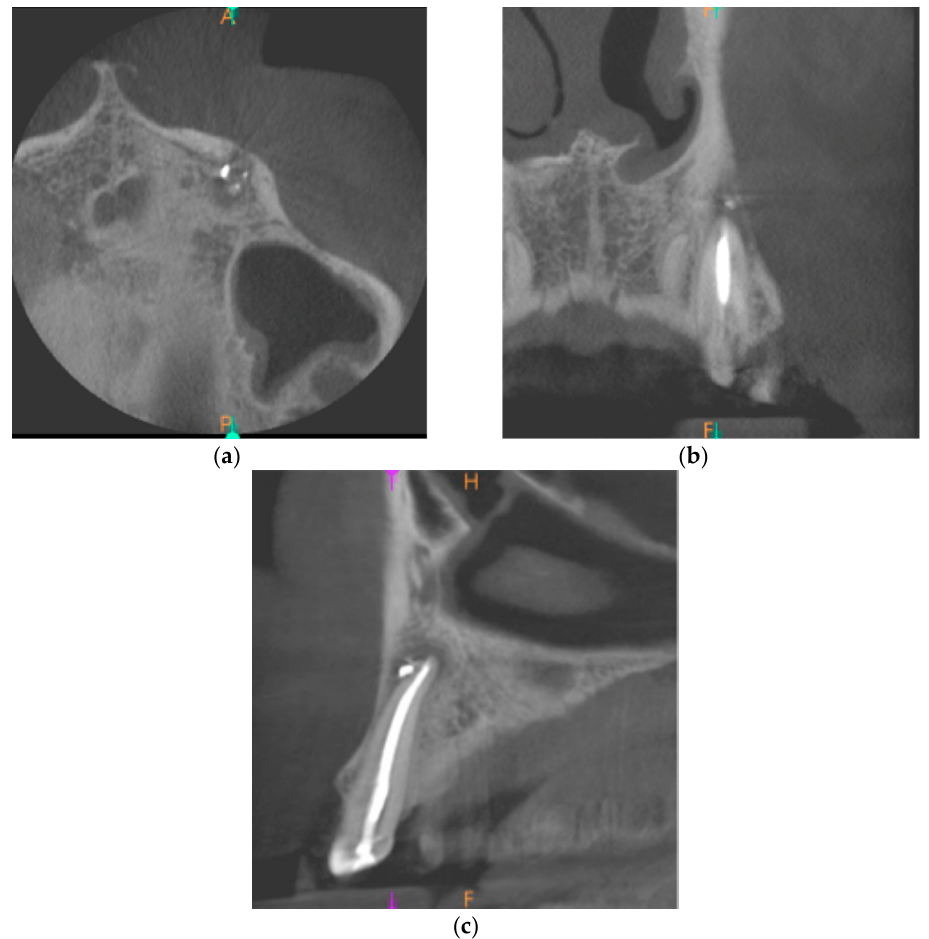
Figure 6. CBCT images presenting the healing process of the periapical lesion around the root of tooth no. 23 (date of CBCT examination: 29 June 2021): ( a ) axial view; ( b ) coronal view; and ( c ) sagittal view.